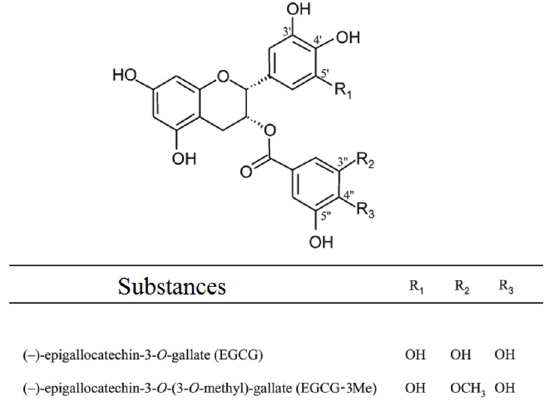
Figure 7. The chemical structure of EGCG and EGCG-3Me. EGCG, epigallocatechin-3-gallate; EGCG-3Me, epigallocatechin-3- O -(3- O -methyl)-gallate.